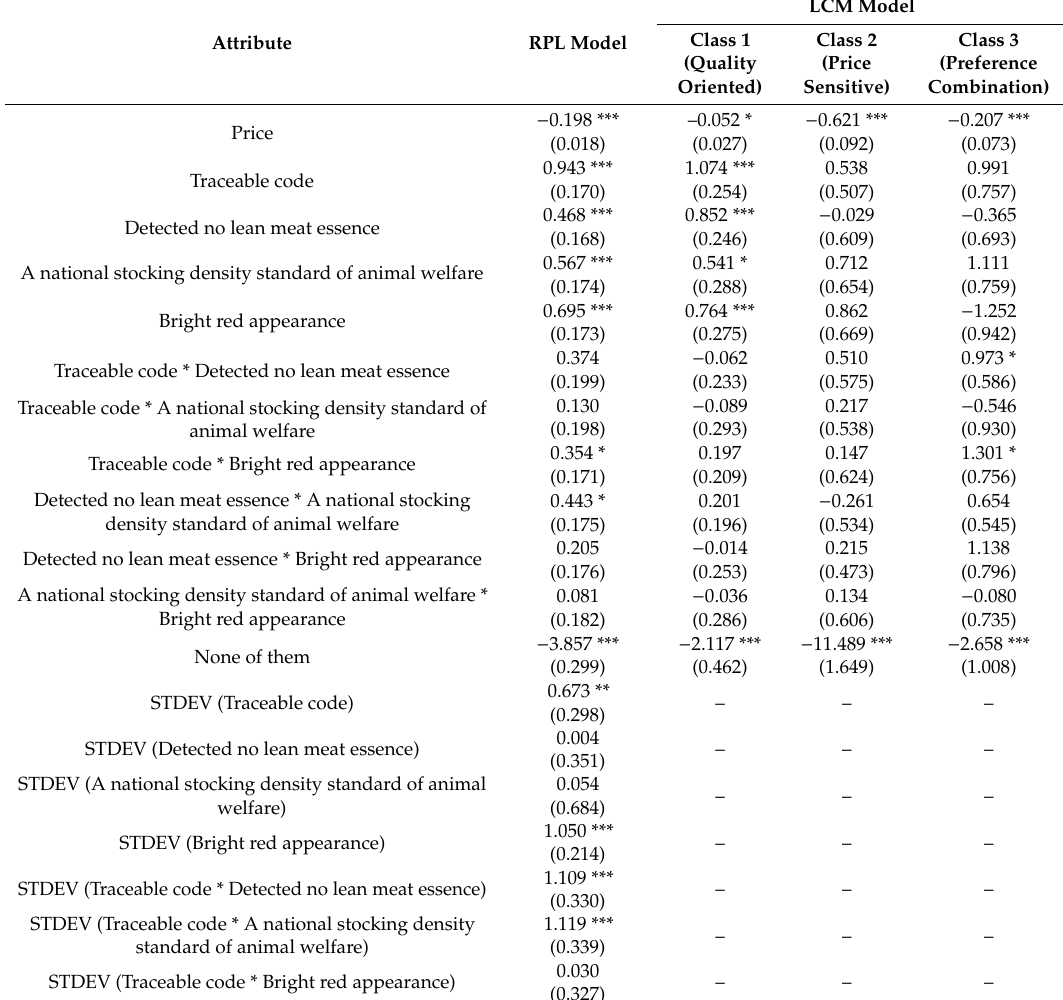
Table 5. Parameter estimation results for the choice experiment using the random parameter logit (RPL) and latent class model (LCM)